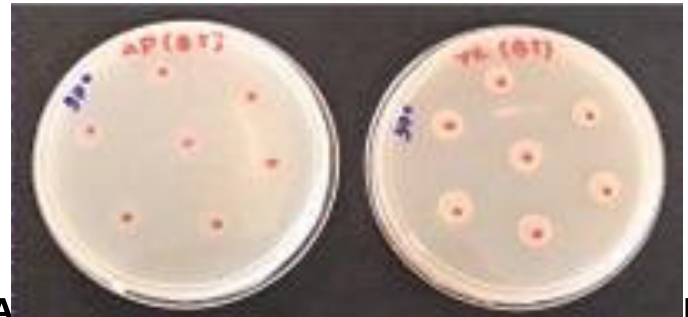
Figure 1. The isolated microorganism from Cassia leptophylla showed no inhibitory activity against Staphylococcus coagulase-positive strain in peptone agar (A) and yeast extract agar